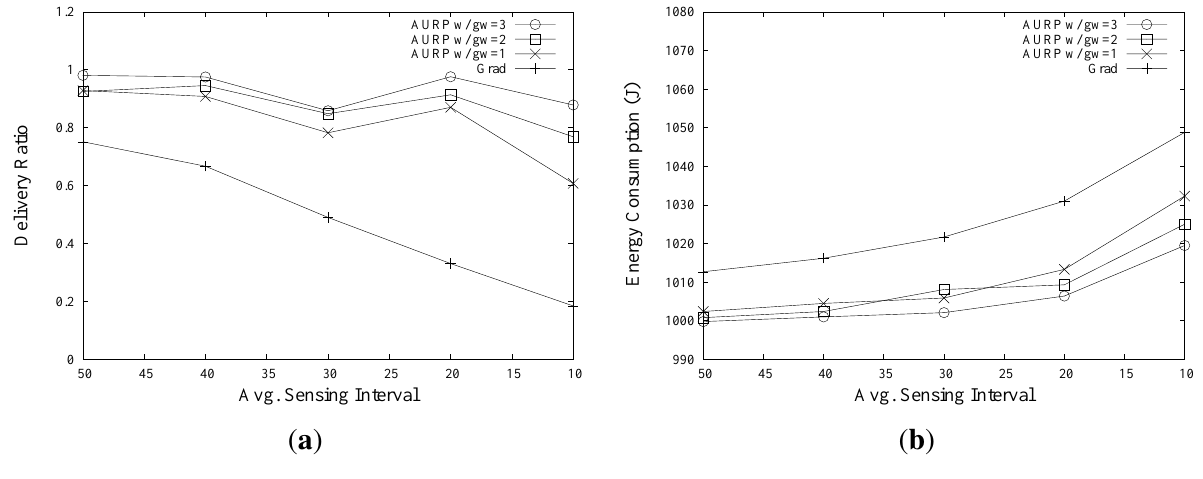
Figure 6. Effects of Network Loads on the network performance.